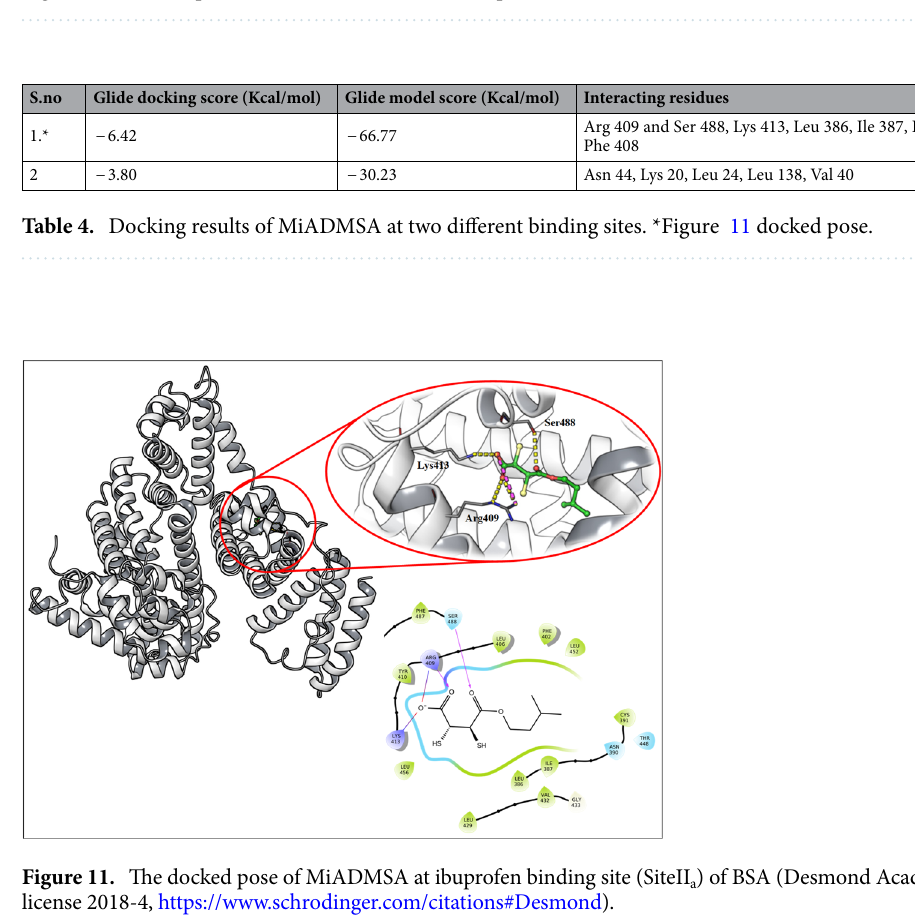
Figure 10. FT-IR spectra of free BSA (blue) and complex of BSA-MiADMSA (red).